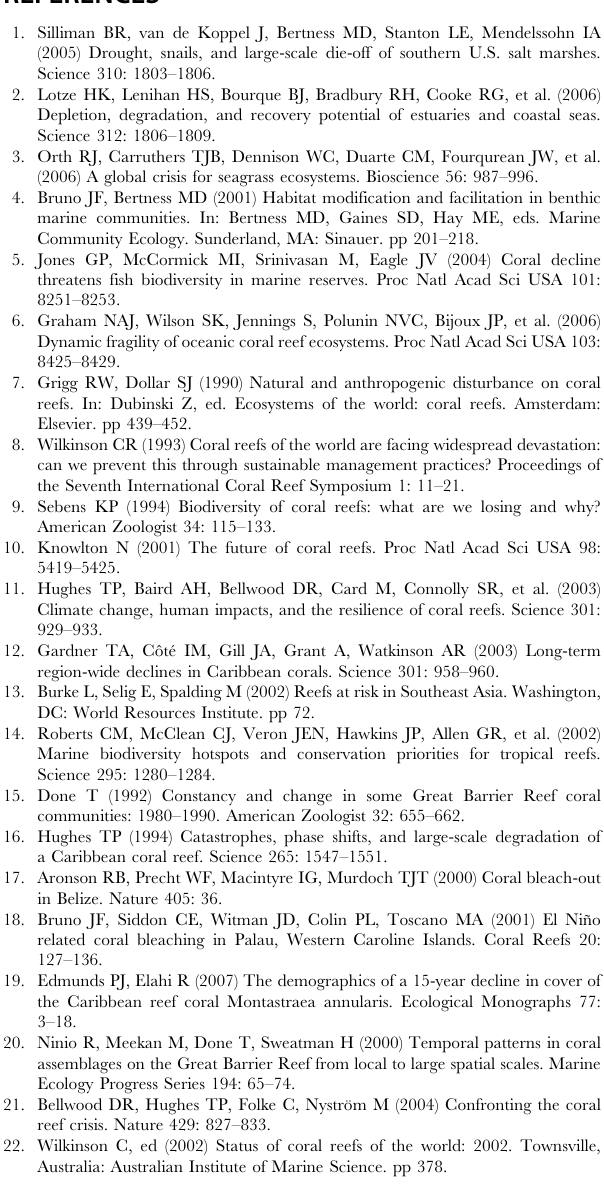
Figure S1 Patterns of coral cover decline in ten Indo-Pacific subregions. Black bars are mean coral cover 6 1 SE for each year (missing bars are years in which no data are available). Open symbols (right axis) are the number reefs surveyed in each subregion during each year (note changes in scale). Found at: doi:10.1371/journal.pone.0000711.s009 (0.73 MB EPS) Map S1 Locations of the 2667 surveyed reefs (green dots). (This KML file can be viewed with the Google Earth mapping